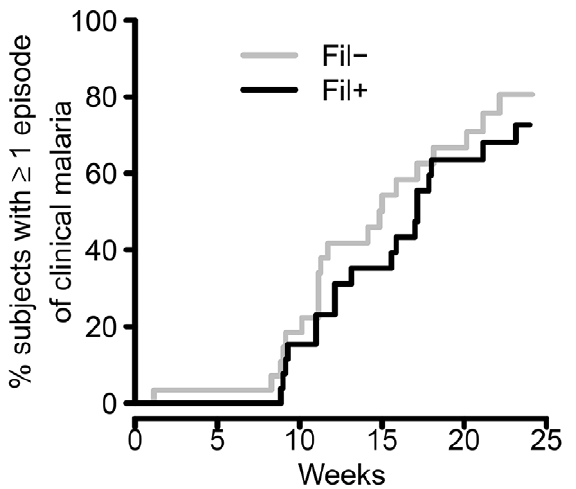
Figure 4. Parasitemia at the time of the first episode of clinical malaria. The symbols represent individual values for FIL + (black circles) and FIL 2 (gray circles) subjects. The horizontal lines represent the GM values for the